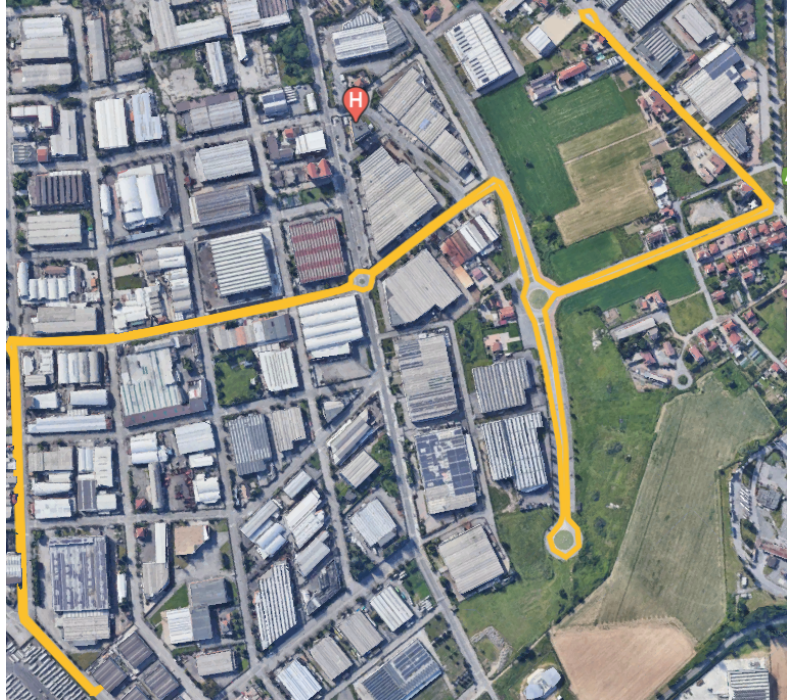
Figure 7. Selected route in Turin, Italy, for performing on-road tests for the prototype two-wheeler. The route is driven to calibrate the battery